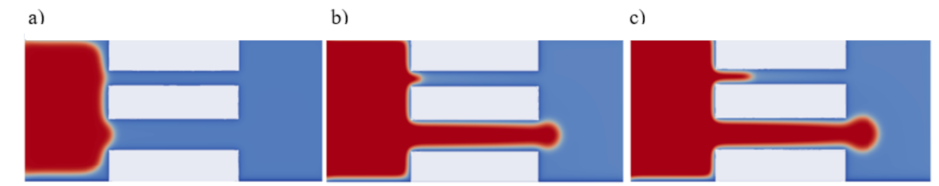
Figure 3. Capillary pressure test results at different ∆ p : ( a ) ∆ p 1 = 1.04 × 10 − 3 ; ( b ) ∆ p 2 = 2.13 × 10 − 3 ; ( c ) ∆ p 3 = 4.3 × 10 − 3